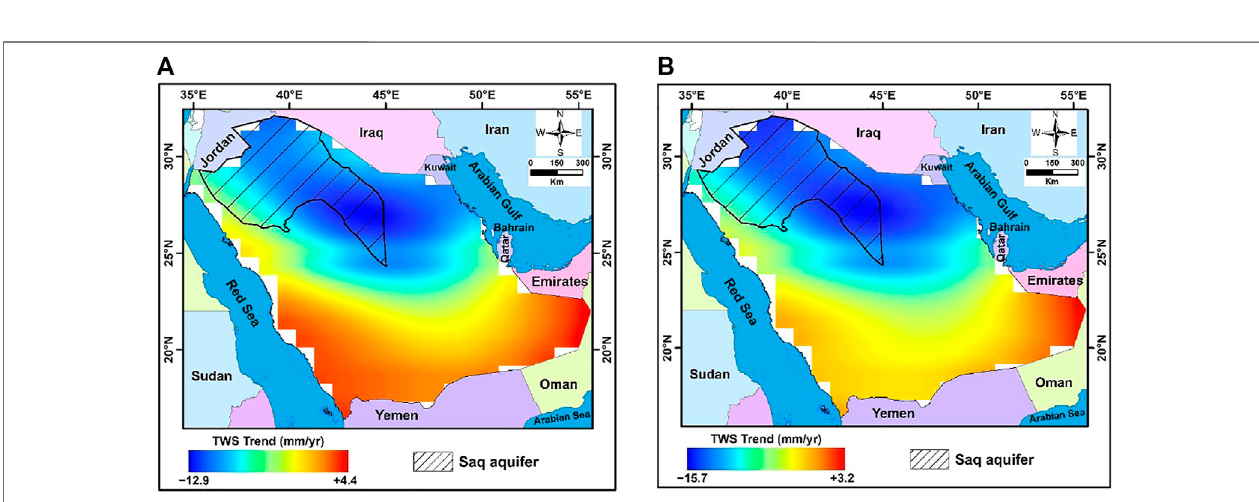
FIGURE 7 | Secular Color-coded GRACE-derived Δ TWS trend map throughout the investigated period from averaging of the monthly CSR spherical harmonic solution (A) , and JPL spherical harmonic solution (B) over the Saudi Arabia. Also showing the location of the Saq aquifer.